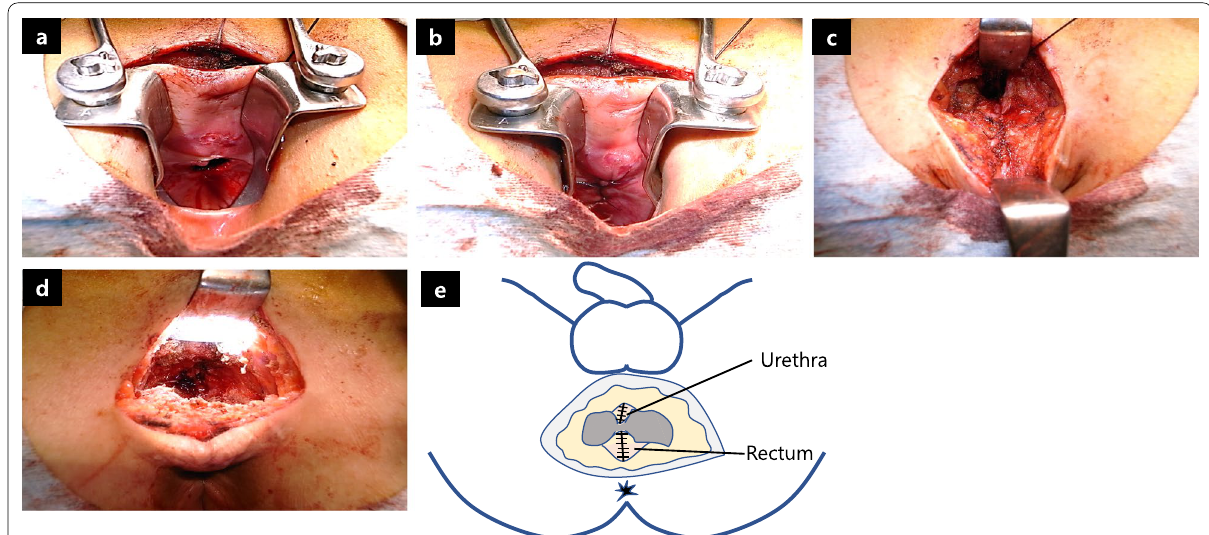
Fig. 3 Intraoperative images. a Opening of the rectal mucosal surface. b Rectal mucosal closure via the transanal approach. c Adventitia of the rectum was closed from outside with absorbable sutures. d Urethra opening was closed with absorbable sutures. e Illustration of closure of the